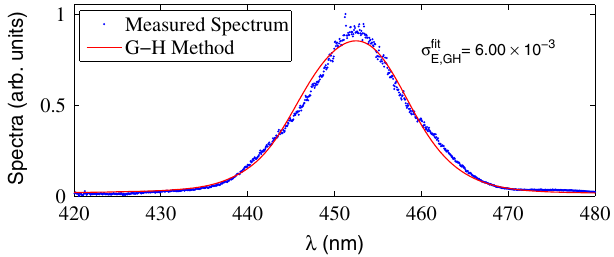
FIG. 18. (Color) Measured optical klystron spectrum with a very large energy spread. The electron beam energy is 400 MeV and the single-bunch beam current is 40 mA. The FEL interaction is turned on to increase the energy spread. The buncher magnet is ¼ 1 : 06 . The G-H method powered with a small current with N d is used to find the energy spread of the beam, (cid:1) fit E ¼ ð 6 : 00 (cid:9) 0 : 029 Þ (cid:2) 10 (cid:1) 3 . The background of the measured spectrum has